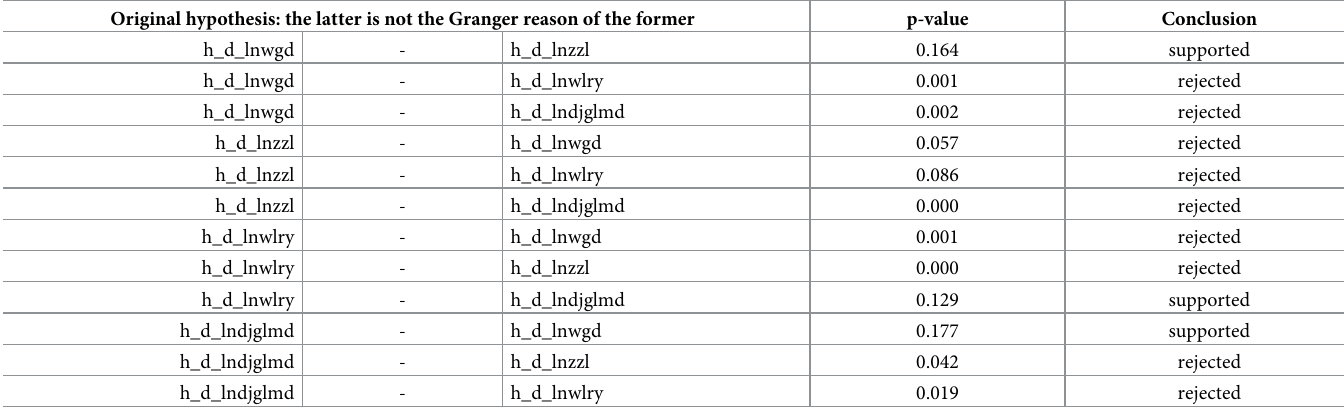
Table 23. Granger causality test of logistics industry and the efficiency of two-industry-linkage. Original hypothesis: the latter is not the Granger reason of the former